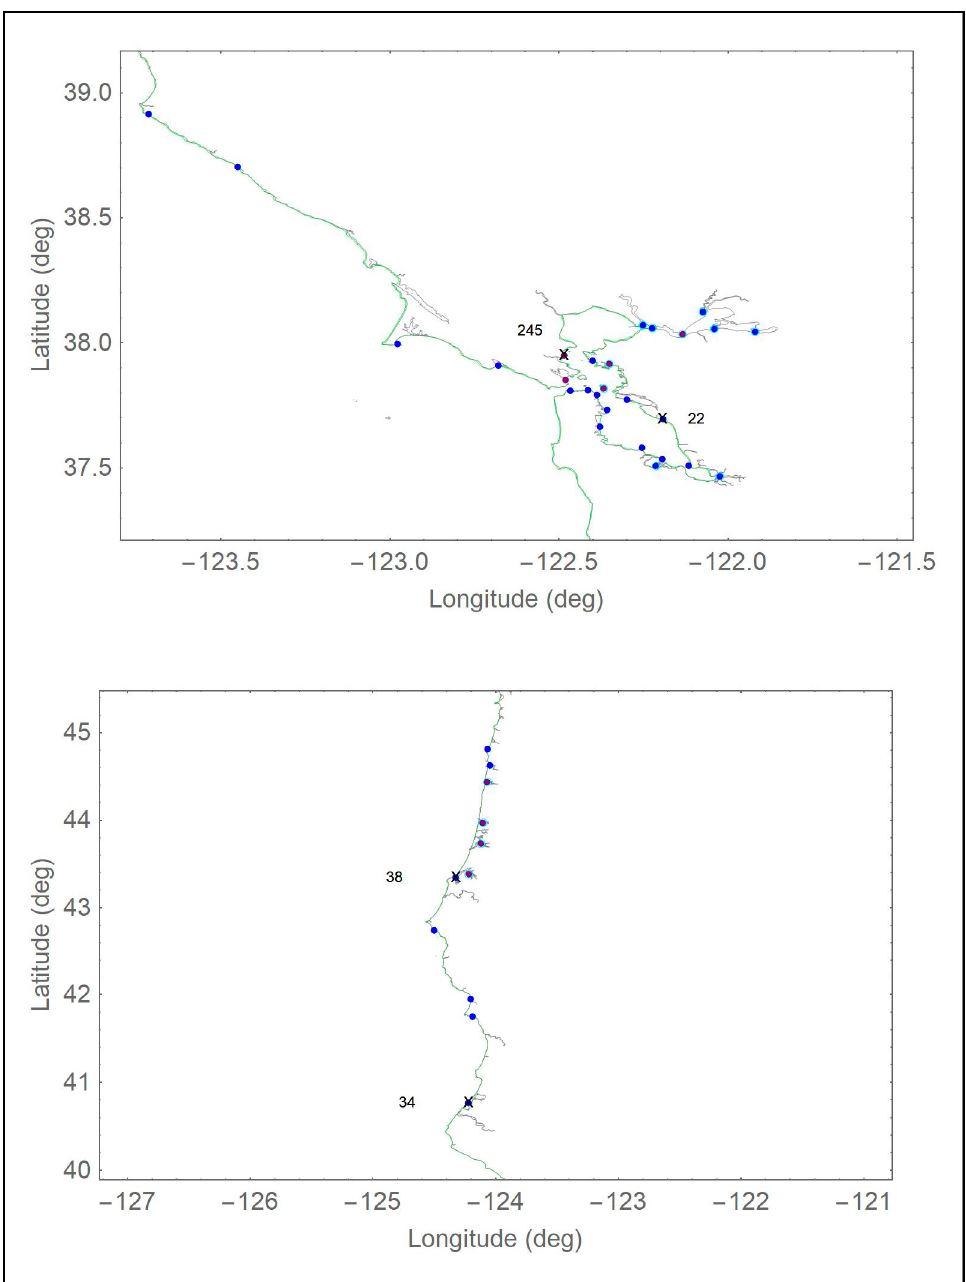
Figure A2. Location of validation stations: San Francisco Bay and Northern California.